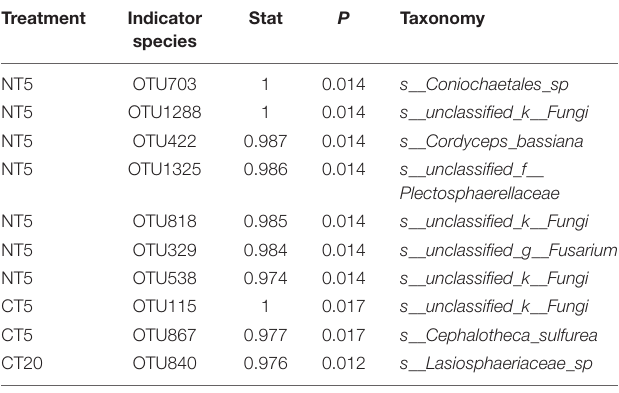
TABLE 2 | Indicator species of fungal community under NT and